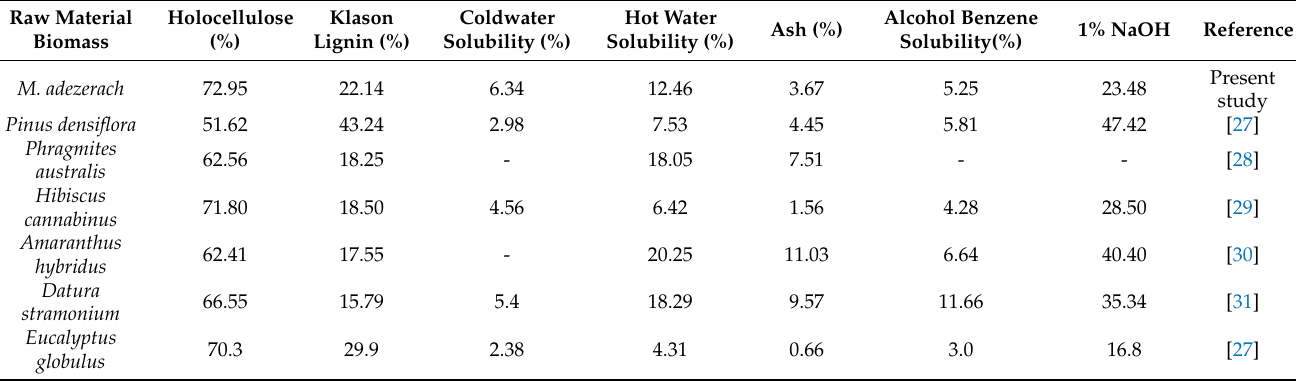
Table 1. Proximate chemical analysis of M. azedarach and other raw